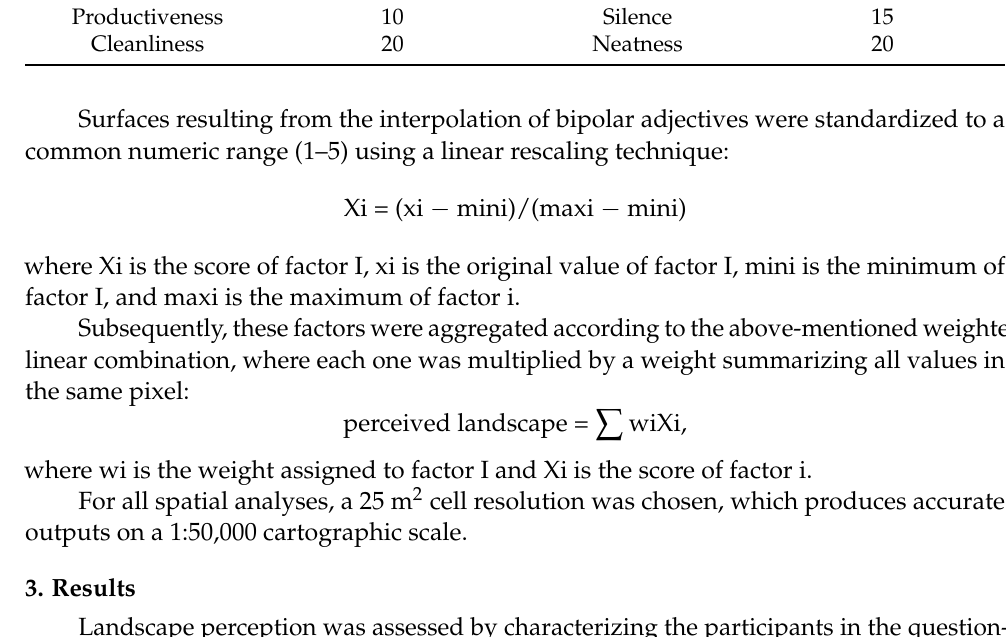
Table 2. Weight (%) considered for each landscape concept. Landscape Characteristics Landscape Experiences Concept Weight Concept Weight Naturalness Peacefulness Attractiveness Interest Productiveness 10 Silence Cleanliness 20